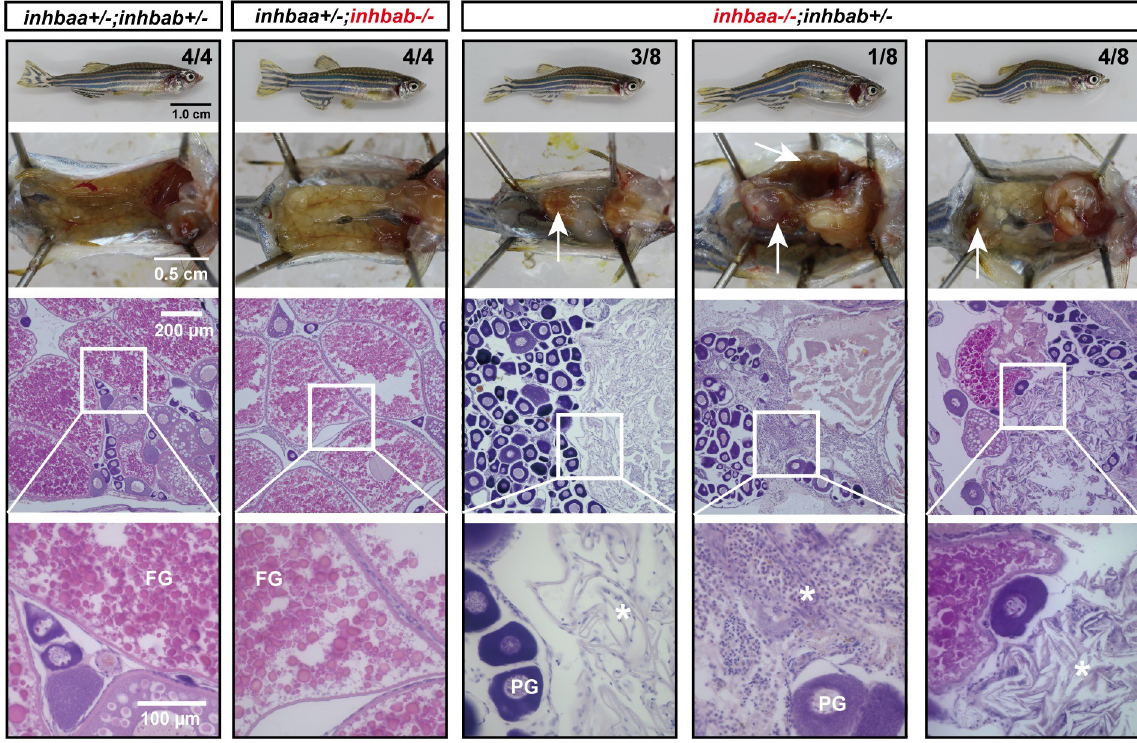
Fig 10. Long-term effect of inhbaa deficiency on ovarian maintenance. Tumour/cyst-like tissues (arrow) accumulated in the ovary of all individuals examined at ~18 mpf ( > 540 dpf). The folliculogenesis had ceased with follicles arrested at PG stage and the ovaries contained abundant stromal cells and fibrous tissues (asterisk). The control and inhbab-/- fish showed normal ovarian structure. The boxed areas are shown at higher magnification below. The numbers shown in the photos indicate the total number of fish examined (lower) and the fish exhibiting similar phenotype to that shown (upper). PG, primary growth; FG, full-grown.